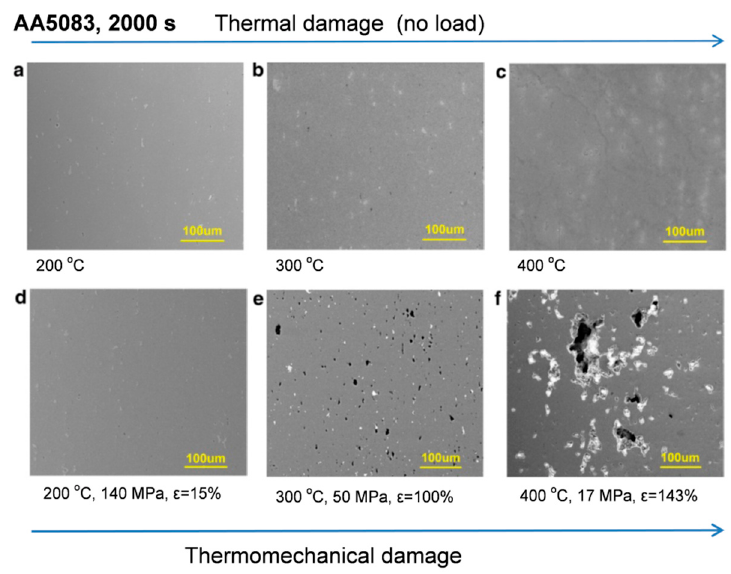
Figure 32. Comparison of ( a – c ) thermally and ( d – f ) thermomechanically damaged 5083 − H116 alloy exposed for 2000 s. The shown conditions are (a) 200 °C, (b) 300 °C, (c) 400 °C, (d) 200 °C, 140 MPa, ε = 15%, (e) 300 °C, 50 MPa, ε = 100% and (f) 400 °C, 17 MPa, ε = 143%. The rolling/loading direction for all micrographs is along the long axis of the page [10].